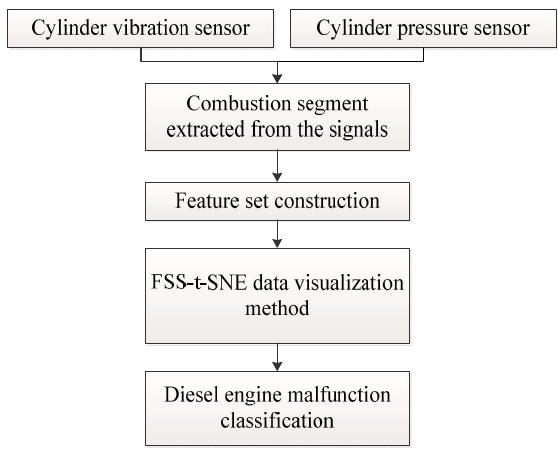
Figure 4. The procedure of the malfunction classification on diesel engines.